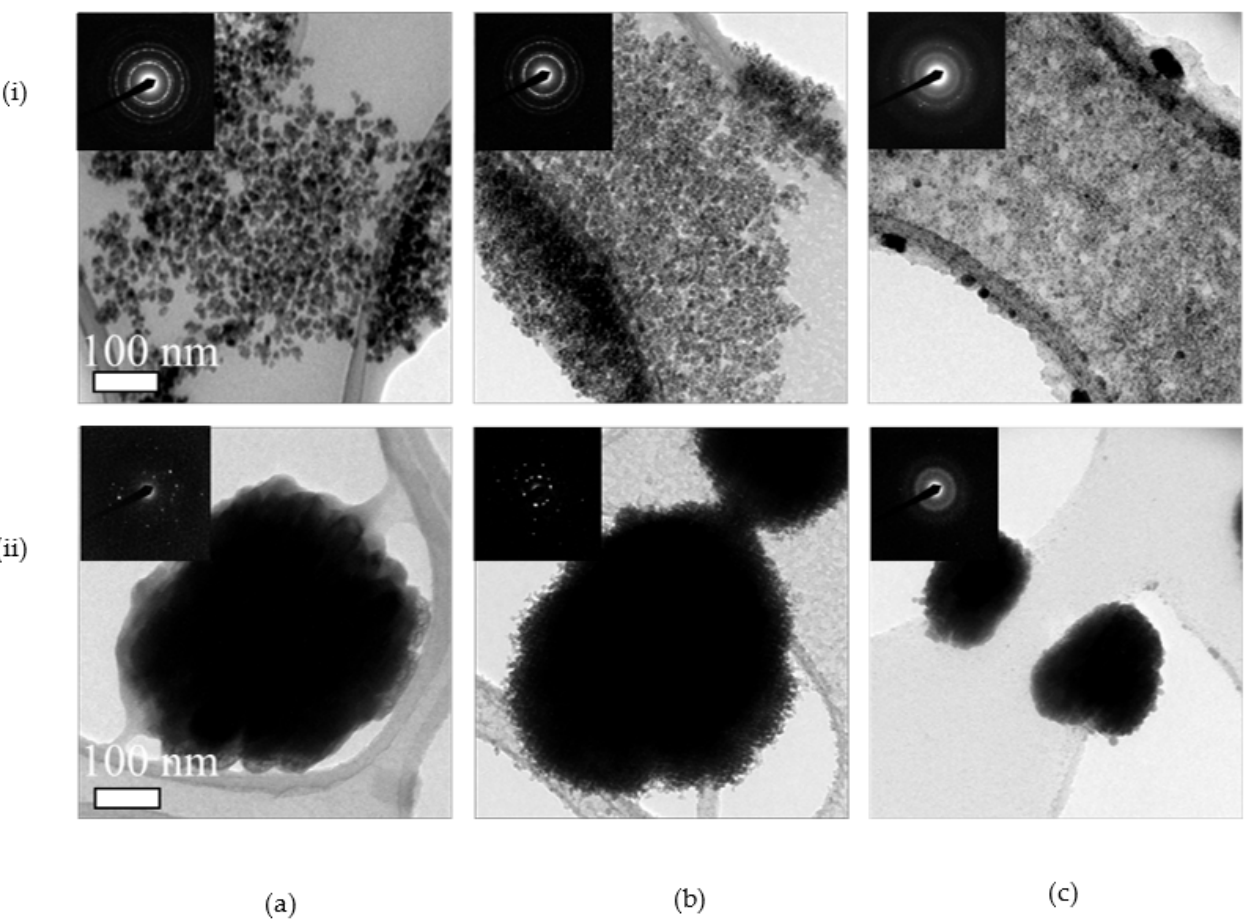
Figure 9. TEM images and SAED patterns of ( i ) CeO x and ( ii ) Eu:CeO x nanoparticles generated from HMTA preparation route during ion irradiation: ( a ) green, ( b ) 1 × 10 13 cm − 2 , and ( c ) 1 × 10 15 cm − 2 . Respective SAED patterns are displayed in the inset of each micrograph. Scale bars are 100 nm in all micrographs.